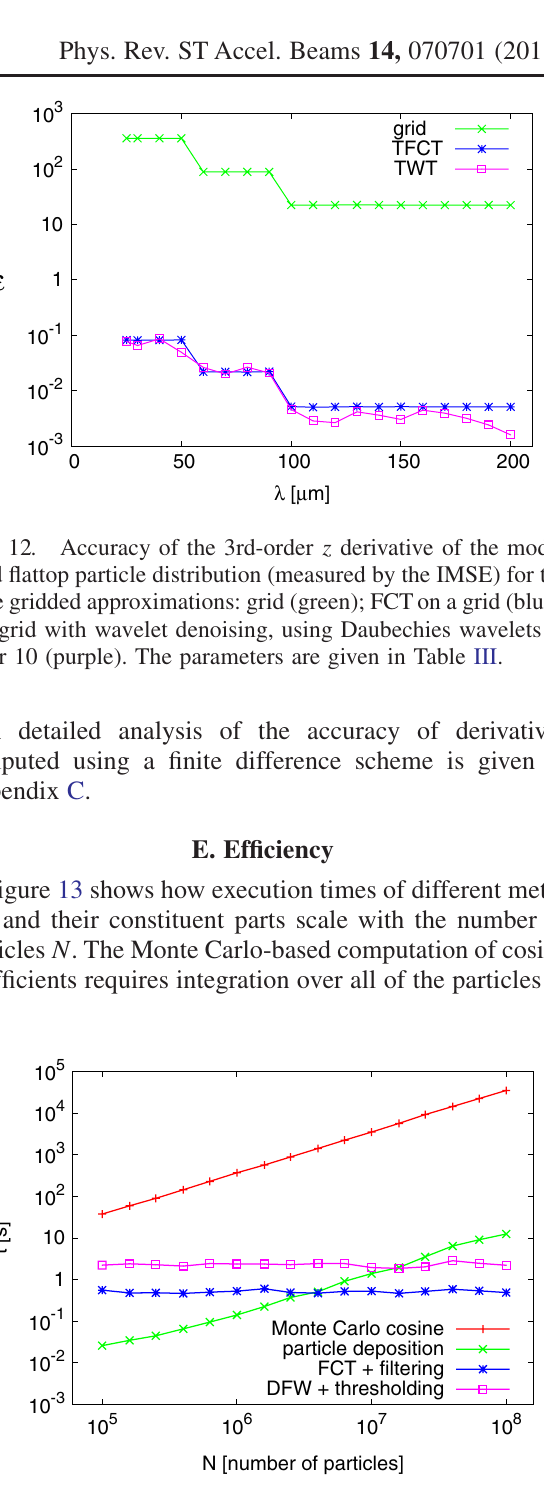
FIG. 13. Execution time of different approximations and their parts, as a function of the number of particles N : Monte Carlo cosine (red), charge deposition (green), FCT and filtering in Fourier space (blue line), and DWT and wavelet thresholding ¼ 1024 , N ¼ 128 , and the (purple). The grid resolution is N z x ¼ 100 number of cosine basis functions in the expansion is M z ¼ 40 . Wavelet family used is Daubechies of order 10. and M x (cid:8) ¼ 100 (cid:9) m and A ¼ 0 : 05 . The simulation was executed on a dual Intel ð R Þ Xeon ð TM Þ 3.06 GHz CPU Pentium with 2 Gb mem- ory, running Linux